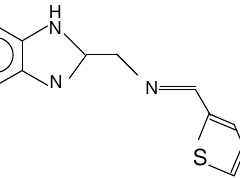
Figure 1. Structure of Schiff